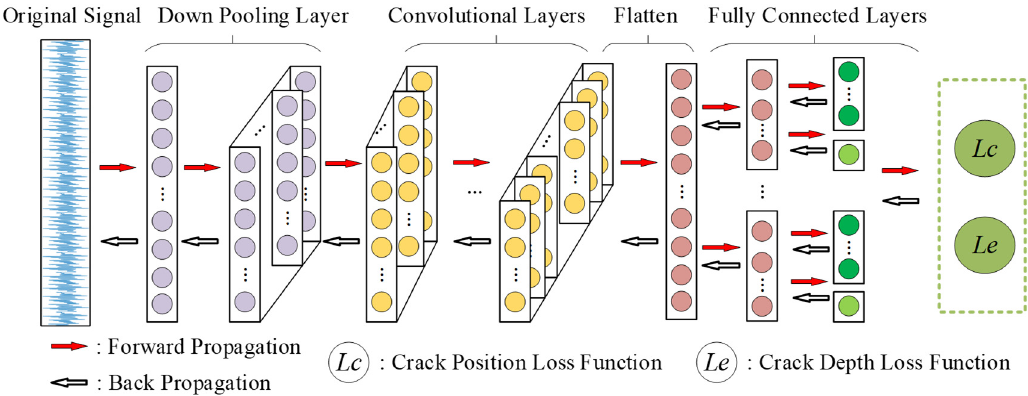
Figure 4. Convolutional neural network structure.